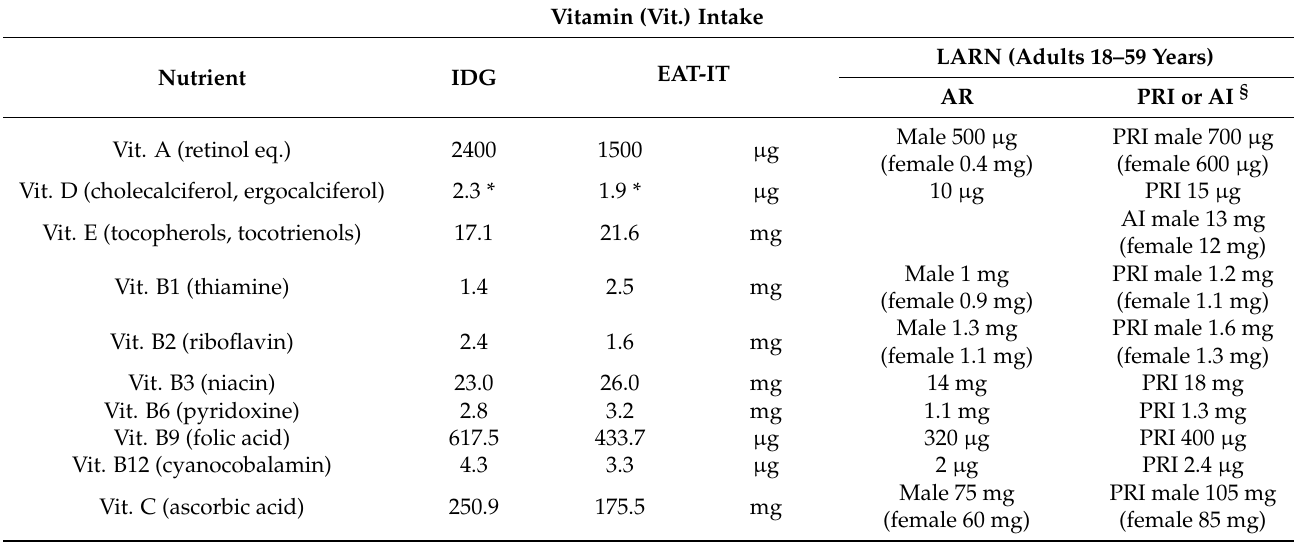
Table 5. Comparison between the vitamins provided by the IDG and EAT-IT dietary plans for a 2500 kcal diet. Vitamin (Vit.) Intake LARN (Adults 18–59 Nutrient IDG EAT-IT